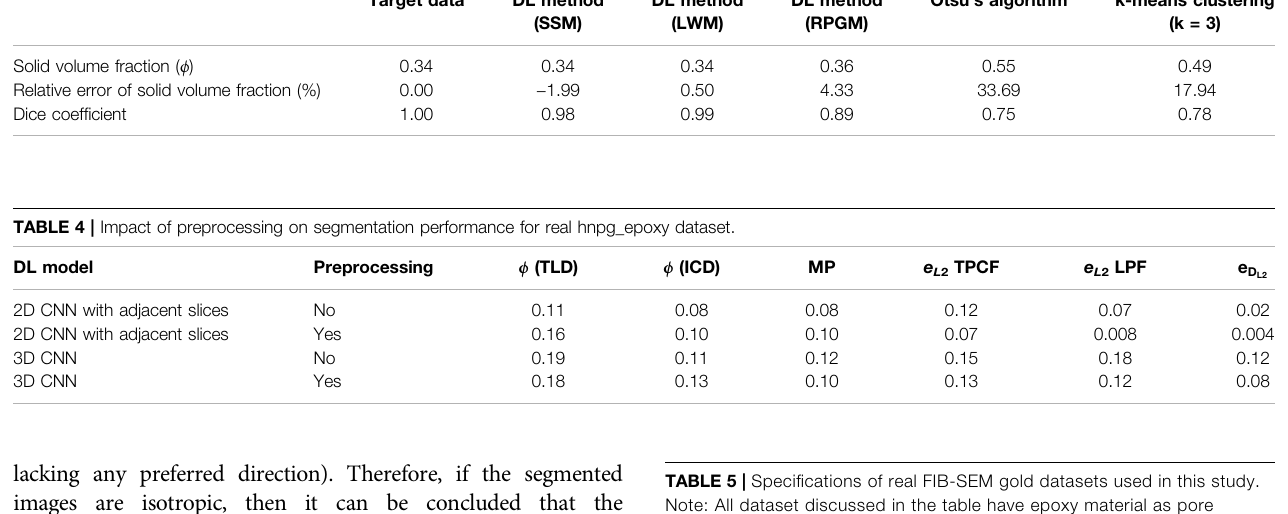
TABLE 3 | Performance of different segmentation methods applied to dataset npg40.